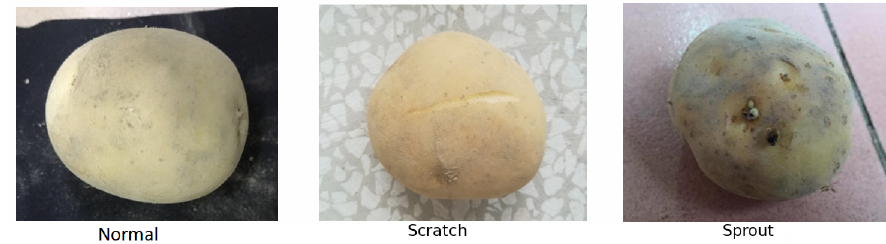
Figure 1. Potato samples.